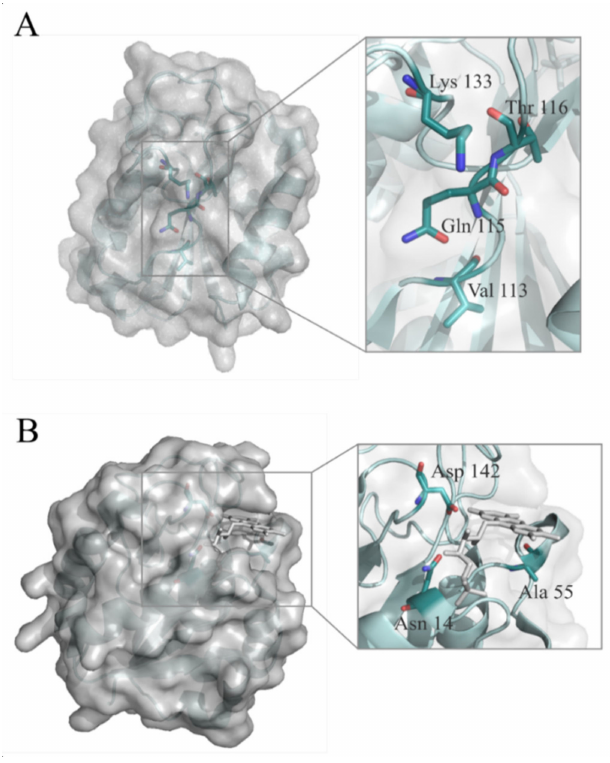
Figure 3. Molecular surface and ribbon models showing putative interacting residues of wild-type Hp -Fld with compounds IV , IV-a , IV-b , IV-c and IV-d . ( A ): Val 113, Gln 115, Thr 116 and Lys 133, predicted by molecular docking, and ( B ): Asn 14, Ala 55 and Asp 142, close to the structural pocket near the cofactor binding site. The FMN cofactor is represented as grey sticks and the nitrogen and oxygen atoms from the amino acid residues are depicted as red and blue sticks,